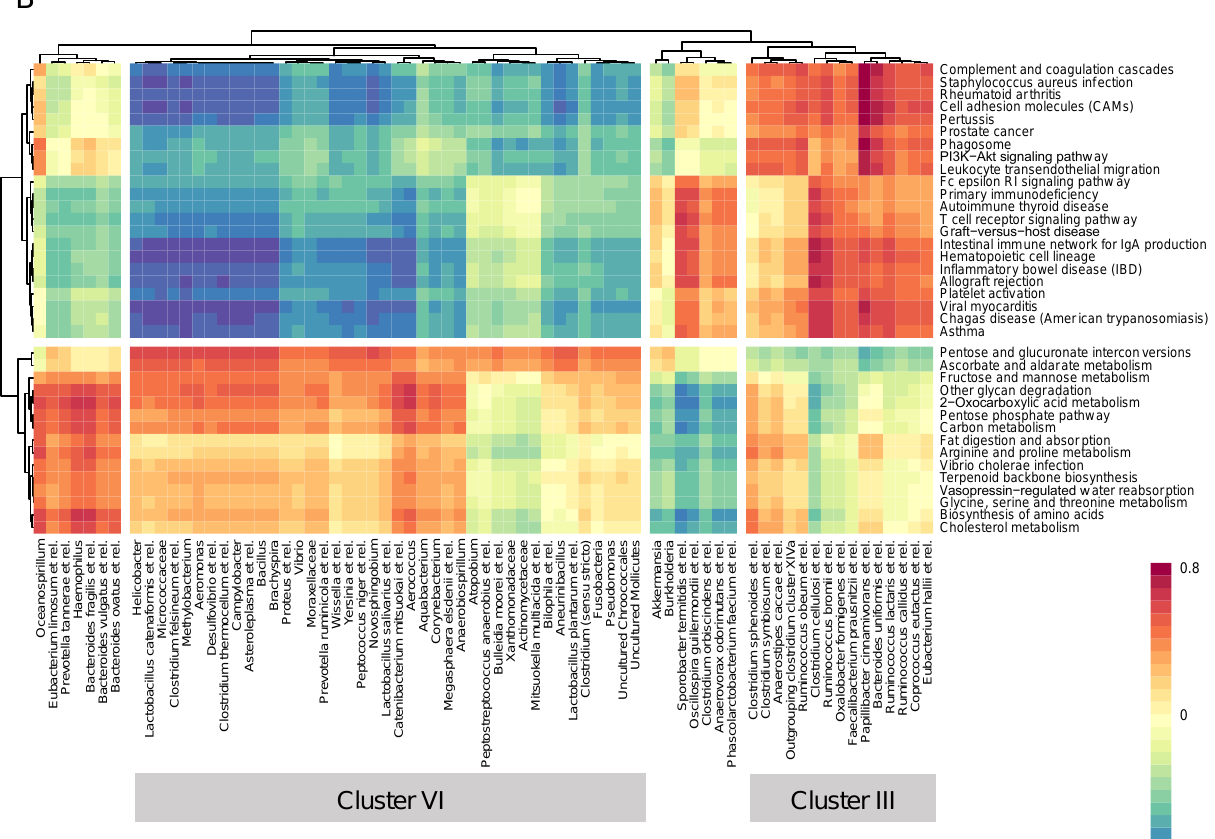
Figure 5. Heat map of correlations between mucosa-adherent microbiota and gene sets affected by FMT. ( A ) Allogenic FMT. ( B ) Autologous FMT. Gene sets differentially expressed in any of the direct comparisons (allogenic vs. autologous FMT, two and eight weeks after FMT, p < 0.01) were included. Correlations with correlation coefficient ( r) > 0.5 are shown. GSVA: gene set variation analysis.